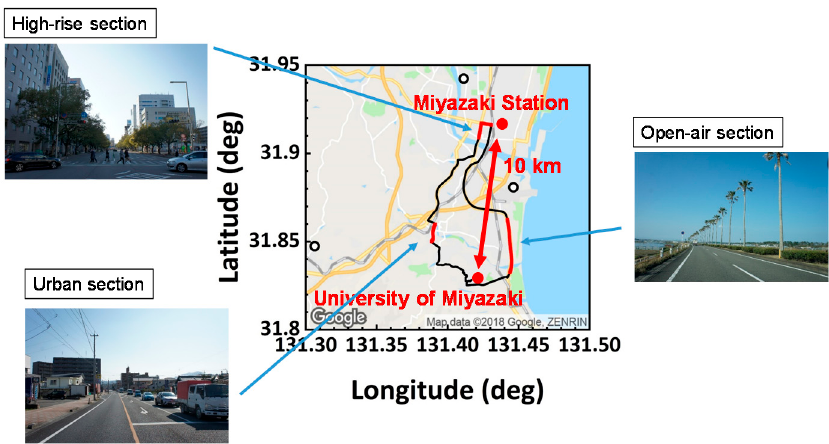
Figure 13. Most frequent driving course of the dynamic solar irradiance measurement in the car.